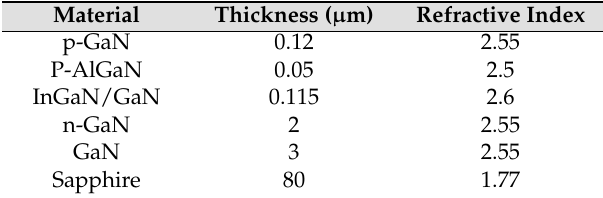
Table 4. Conventional GaN LED Parameters.